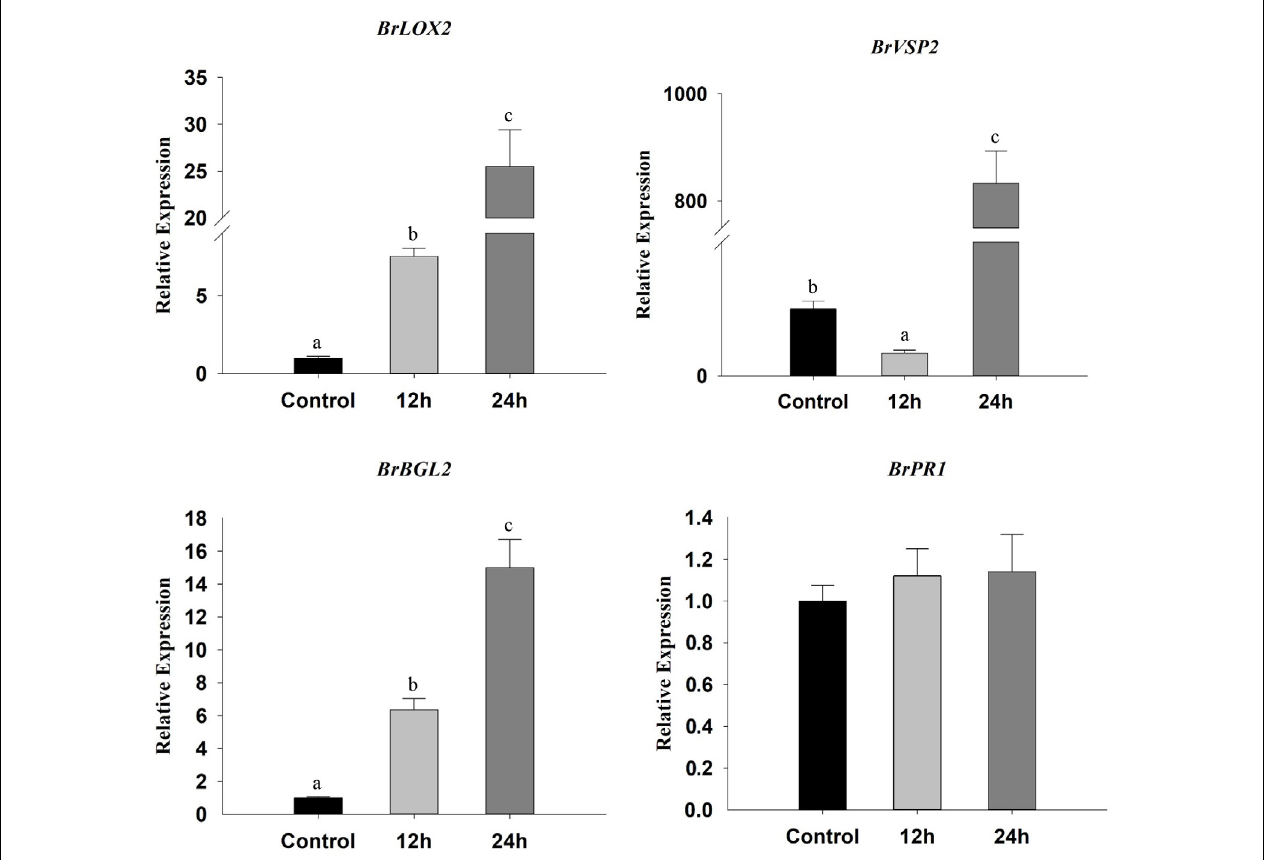
FIGURE 5 | Relative expression levels of SA marker ( BrBGL2 and BrPR1 ) and JA marker ( BrLOX2 and BrVSP2 ) genes in β -ocimene-treated and control Chinese cabbages. OT, β -ocimene treated Chinese cabbage. Different letters over the bars designate a significant difference at P < 0.05.